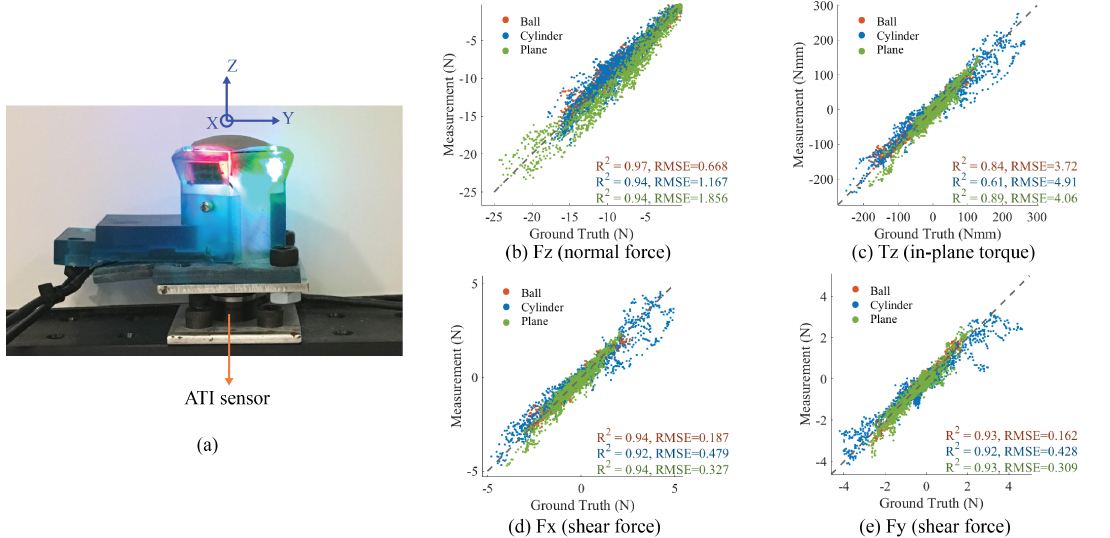
Figure 14. Evaluation on the force measurement of fingertip GelSight with simple but unseen objects. ( a ) experiment setup, where the GelSight is fixed on a ATI Nano-17 force-torque sensor, which is used to measure ground truth. In the experiments, we manually contact the GelSight surface with different objects and different loads. ( b – e ) experiment results of the force torque measurement with different unseen objects, including a ball, a cylinder and a flat plane. The gray dashed line denotes the 1:1 plot where the measurement meets the ground